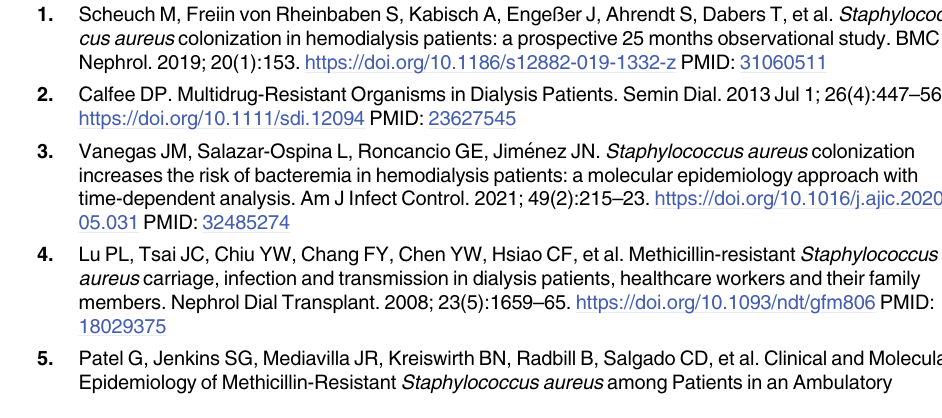
S1 Table. Spa types in methicillin resistant and susceptible S . aureus isolates (MRSA-MSSA) from hemodialysis patients and their household